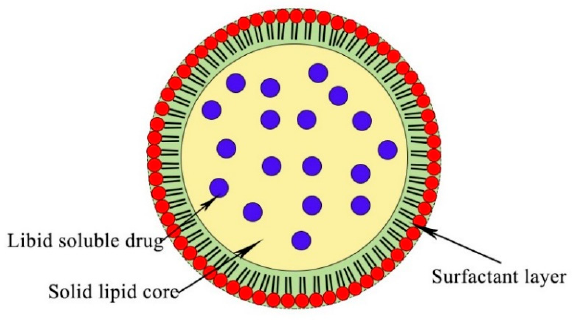
Figure 4. Structure of a solid lipid nanoparticle (SLNP) with lipophilic drugs inserted into its core. The drug molecule distribution in the lipid droplet depends on the use of appropriate techniques and the melting point for the solid lipid.